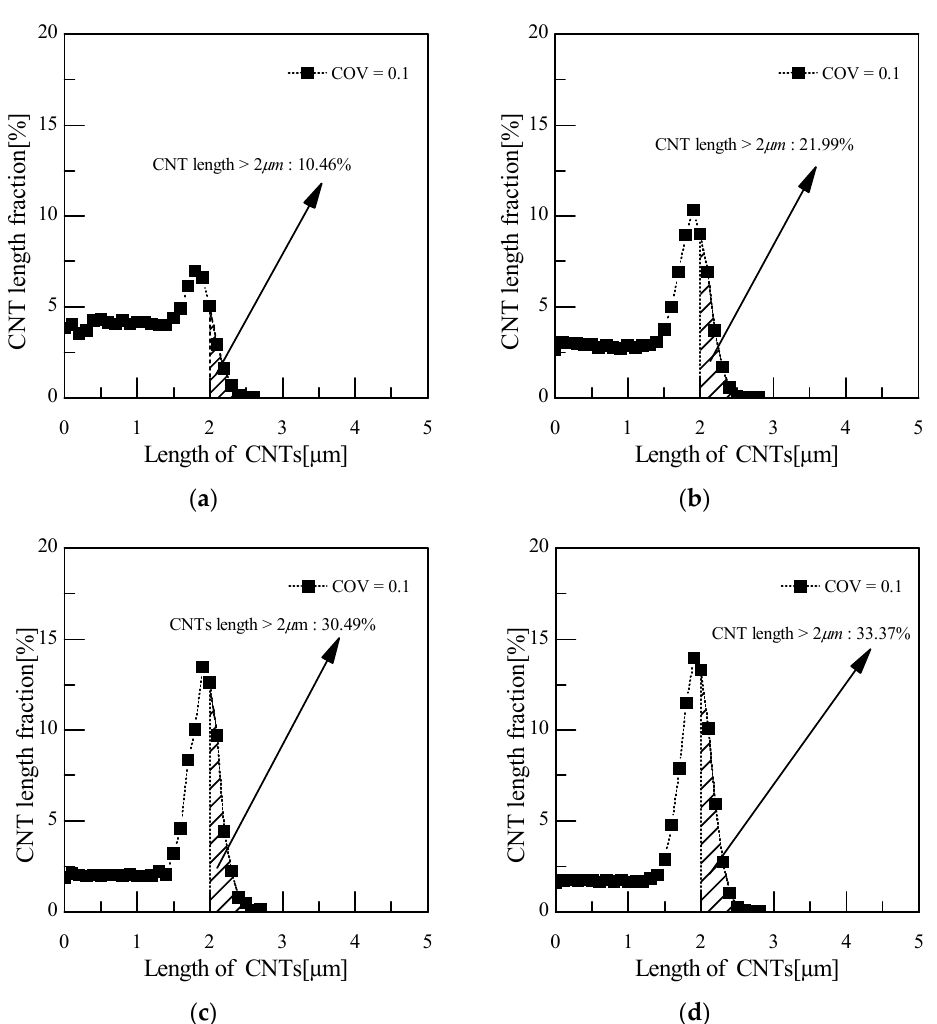
Figure 9. CNT length fraction according to RVE lengths of ( a ) 3, ( b ) 5, ( c ) 8, and ( d ) 10 µm.